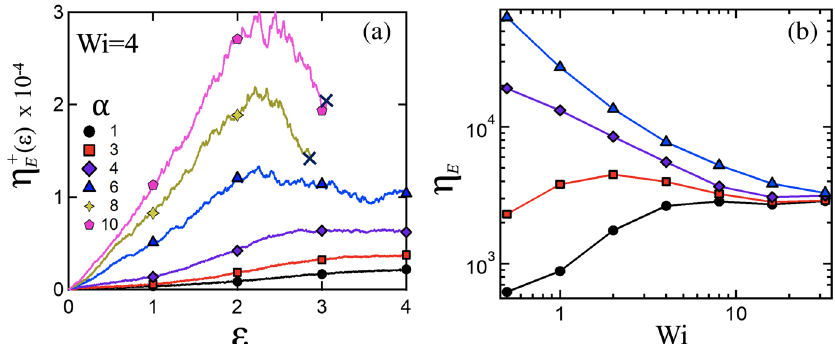
ð ε Þ as a function of Hencky strain ε for association strengths α ¼ 1 , 3, 4, 6, 8, and 10 at a FIG. 2. (a) Transient extensional viscosity η þ E Wi ¼ 4 . A cross indicates the strain at which cavities are observed for α ¼ 8 and 10. (b) Terminal viscosities computed by averaging η over the strain interval from 5 to 10 versus Wi for α ¼ 1 , 3, 4, and